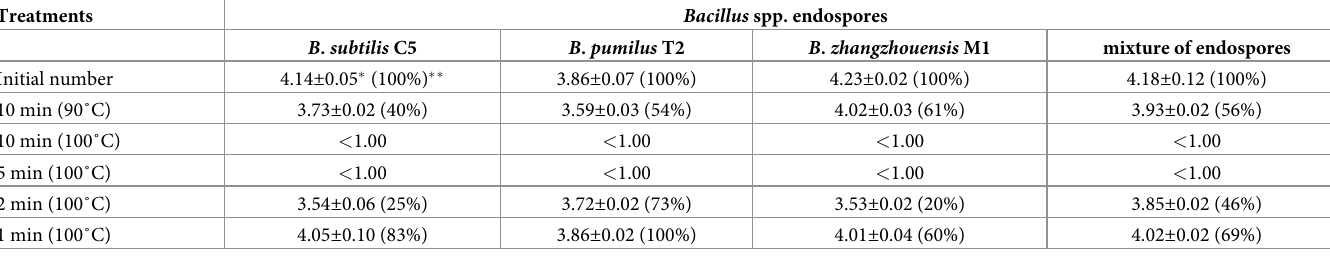
Table 3. Effect of different temperature/time combinations on endospores inoculated in Centella asiatica extract.